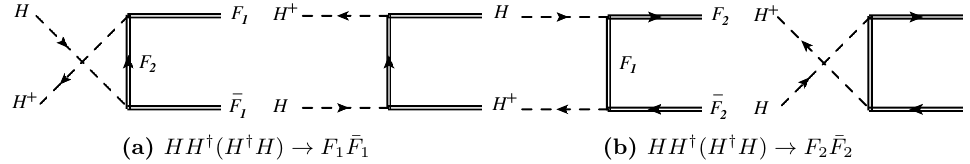
¯ ¯ F 1 , F 2 F 2 , through either a t -channel or a u -channel